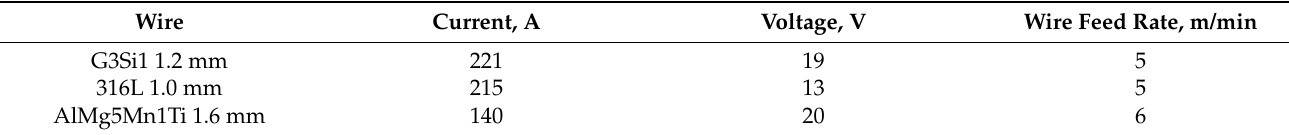
Table 2. Welding parameters in the study of wire melting.